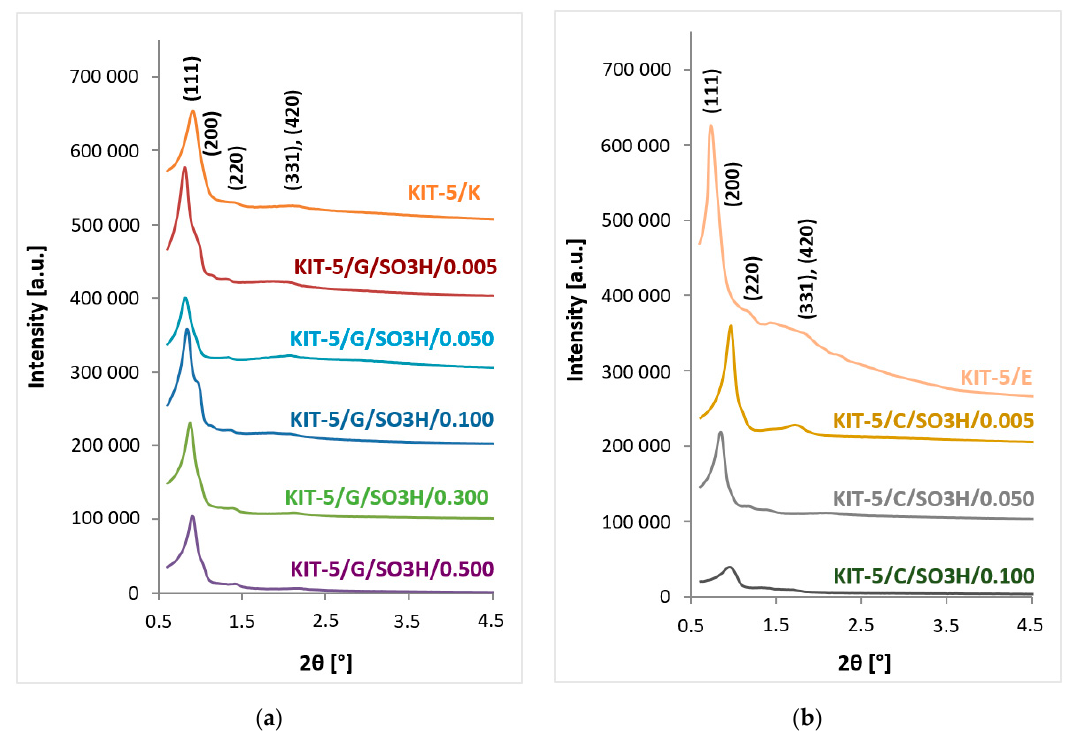
Figure 2. Diffractograms of KIT-5 type materials modified with sulfonic groups by ( a ) grafting or ( b ) co-condensation. Table 1. Unit cell parameters of KIT-5 materials modified with different molar ratios of TEOS: MPTMS introduced by grafting or